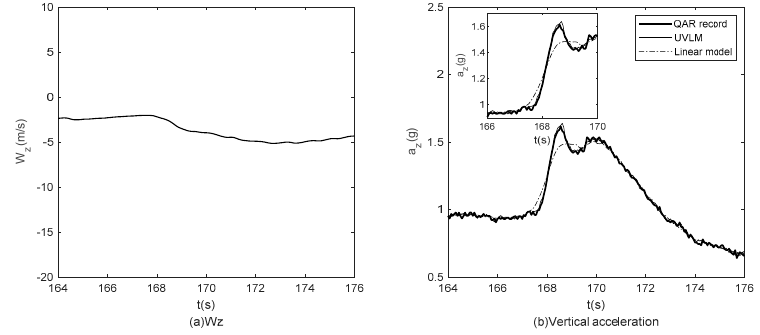
Figure 7. Vertical wind and acceleration response in WF3. ( a ) W z ; ( b ) vertical